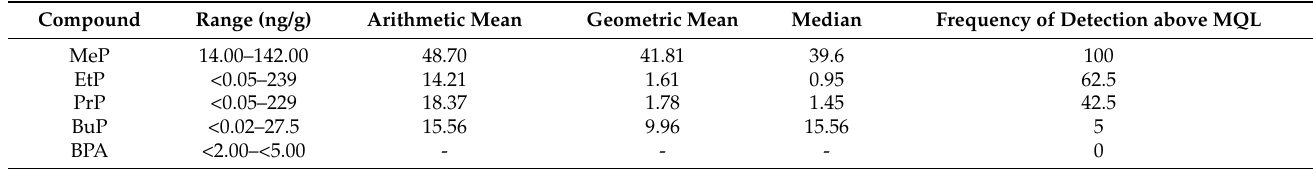
Table 3. (ng/g dw.) and frequency of detection of parabens and bisphenol A in the analyzed guano samples (n = 40)—cumulative data.